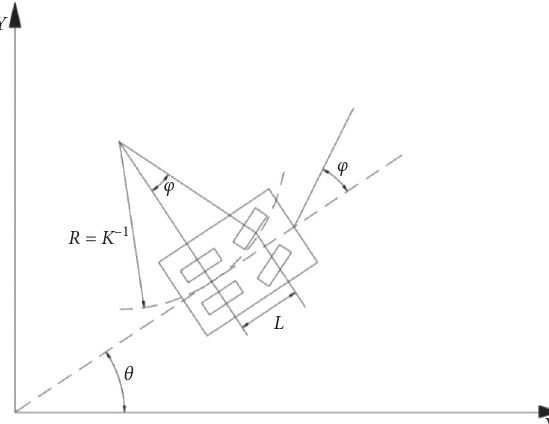
Figure 6: Vehicle kinematics model.